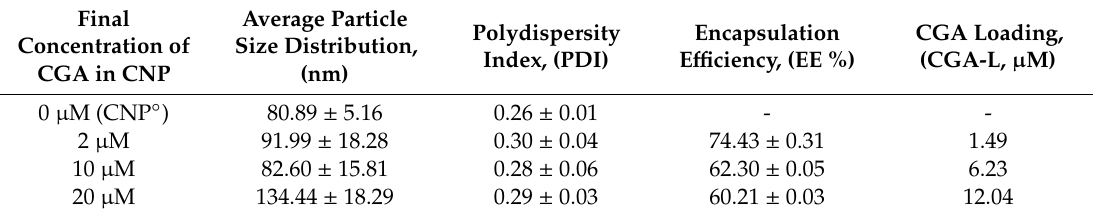
Table 2. The e ff ects of di ff erent CGA final concentrations on polydispersity index, (PDI), average particle size distribution (diameter in nm, nm), and encapsulation e ffi ciency percentage, (EE%) of CNP ◦ . Error bars represent the SD of three independent replicates of the